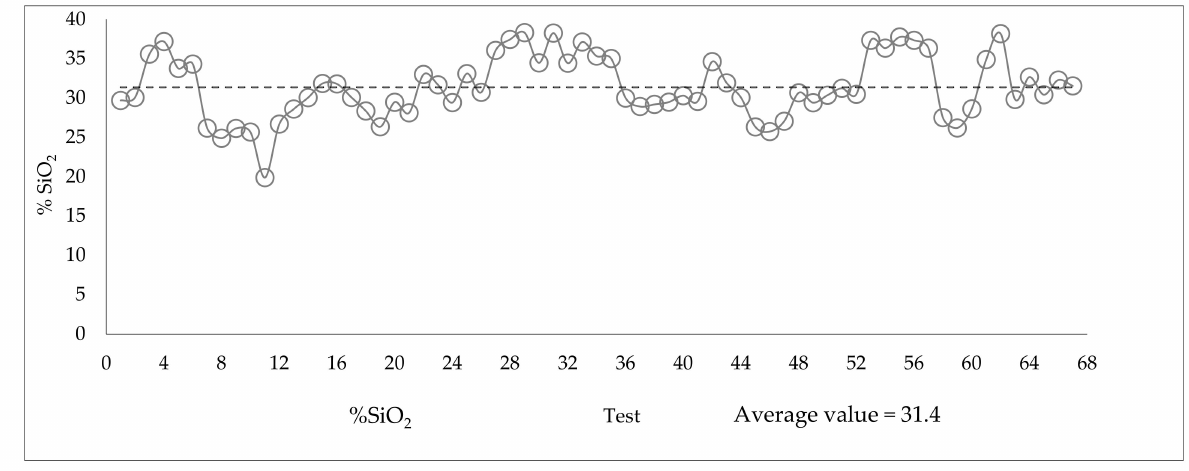
Figure 7. Variation of values concerning the SiO 2 content in the flotation feed during the pilot tests.